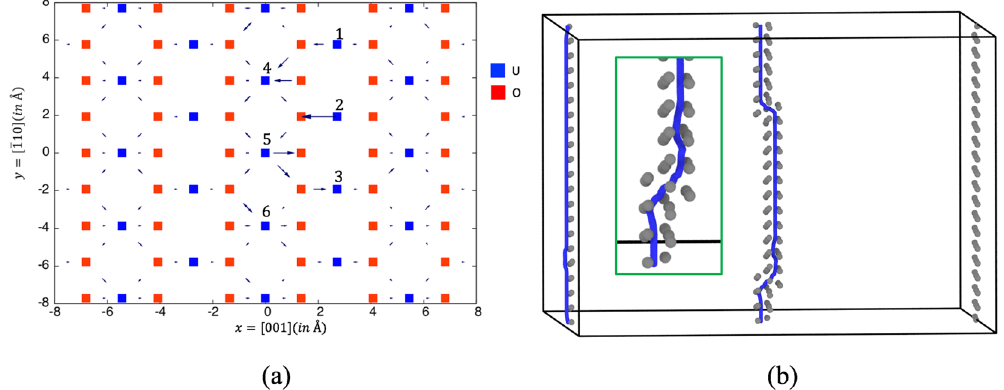
Figure 3. ( a ) The differencial displacement map of the relaxed atomic coordinates through energy minimization for a screw dislocation in UO 2 . The x direction is [001], the y direction is [110] , and the screw dislocation line direction (parallel to z) is [110]. Selected vacancy sites near the dislocation core, analyzed in the text, are labeled. ( b ) A typical dislocation jog pair as observed in the MD simulations of a U vacancy on the screw dislocation (in the middle of the figure). The structure was determined by the DXA algorithm 22 as implemented in Ovito and the view is skewed slightly to emphasize the jog structure. The dislocation lines are indicated with thick blue lines. The grey atoms are U atoms not in fcc, bcc, or hcp coordination environments. The fcc lattice U atoms are hidden for clarity. Inset: an enlarged view of the bottom jog of the jog